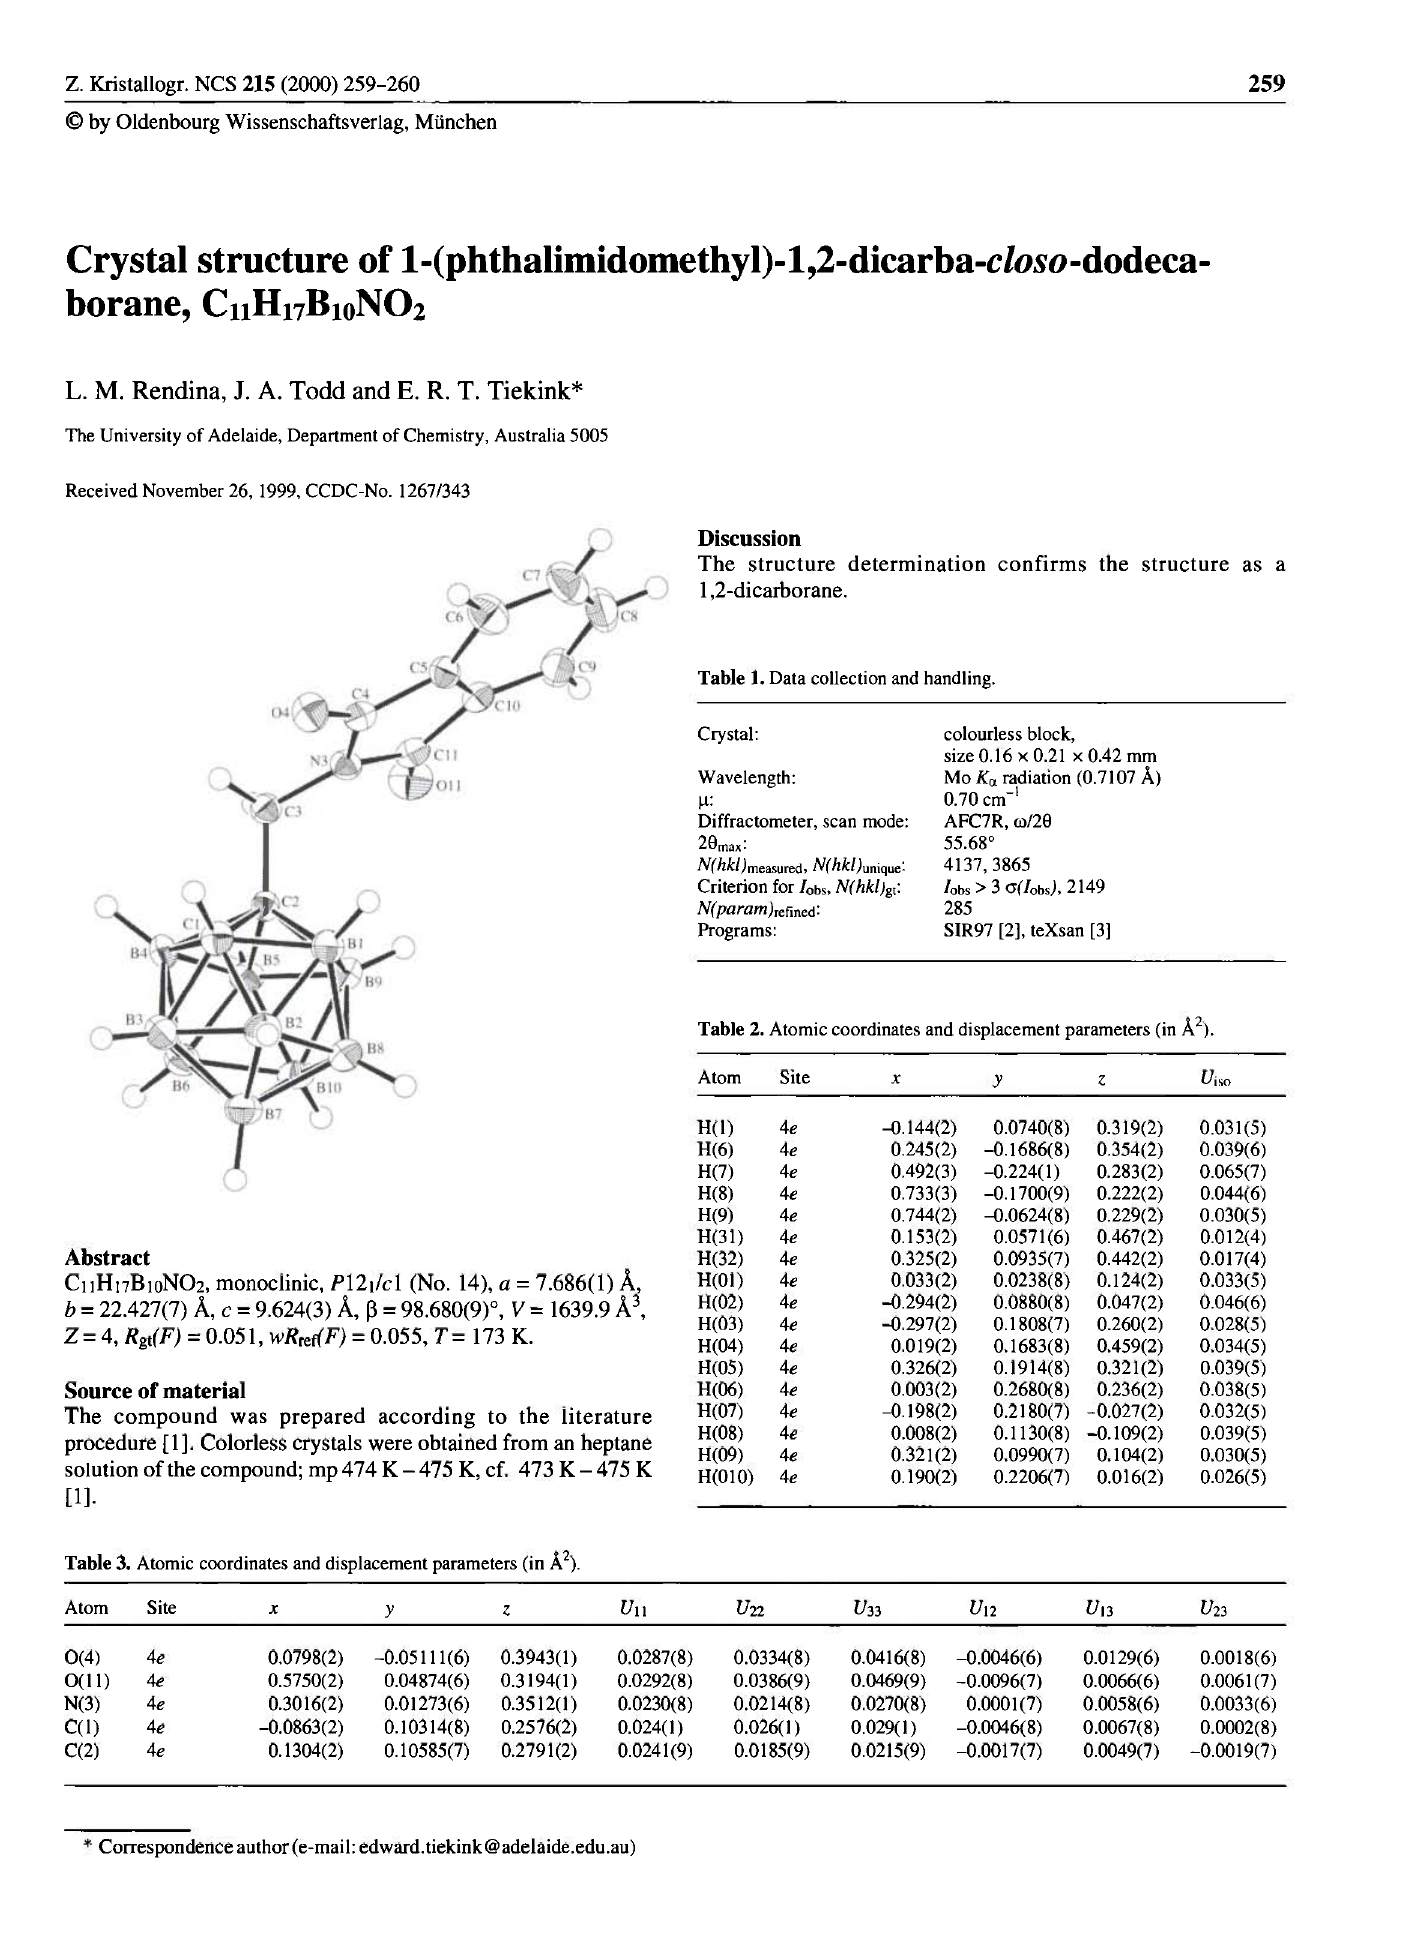
Table 1. Data collection and handling.